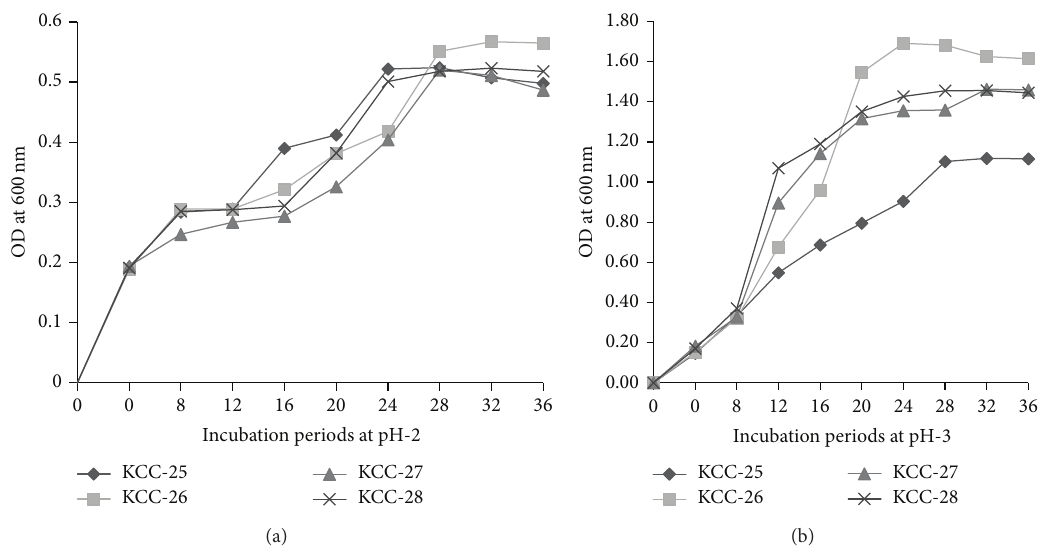
Figure 3: pH resistant properties of L . plantarum KCC-25, KCC-26, KCC-27, and KCC-28. (a) L . plantarum survival ability in pH-2. (b) L. plantarum survival ability in pH-3.